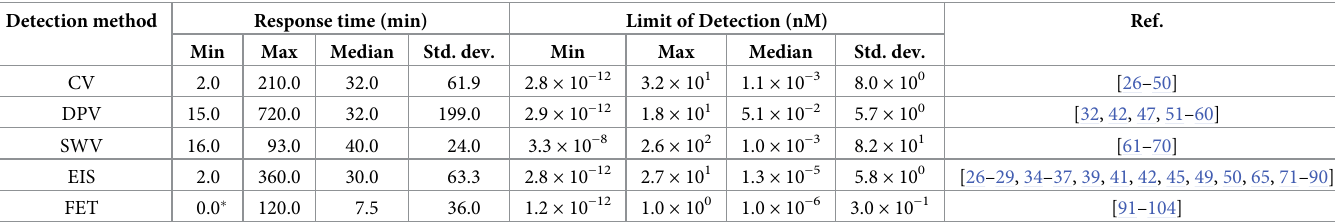
Table 1. Summary table of response time and LoD per detection method. Detection